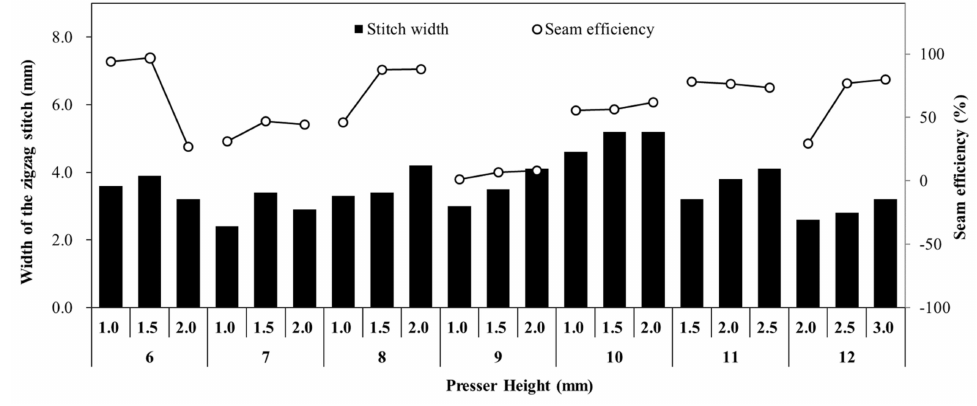
Figure 7. Stitch balance and seam efficiency of the zigzag stitch according to the presser